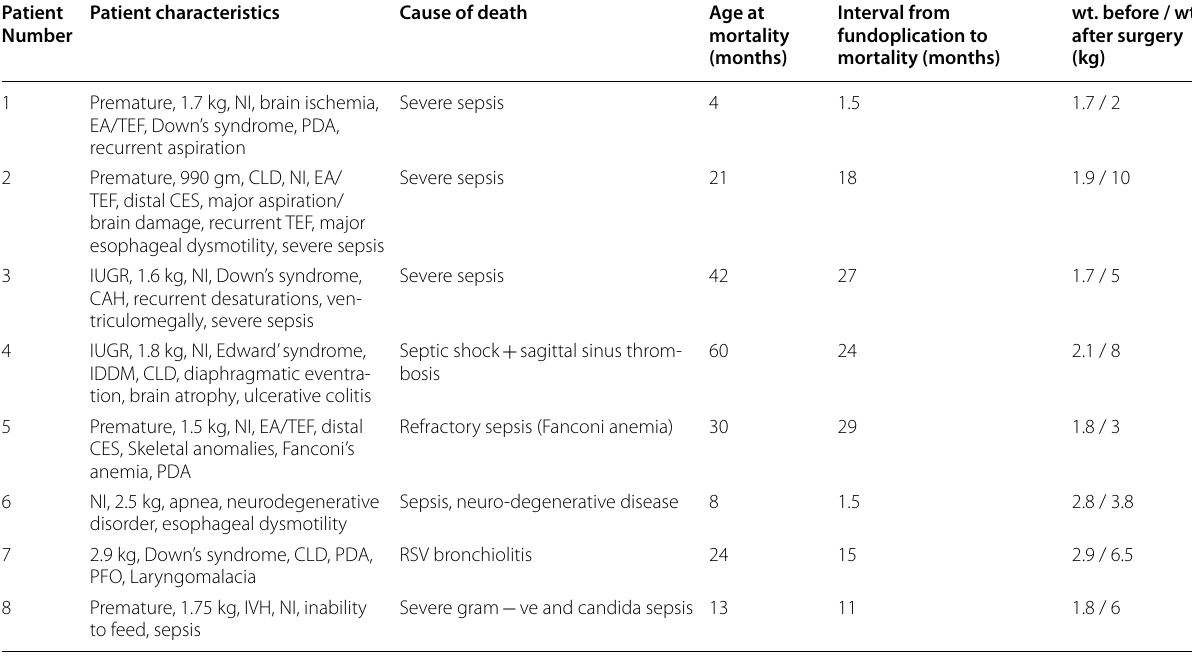
PDA patent ductus arteriosus, IUGR intrauterine growth retardation, CAH congenital adrenal hyperplasia, IDDM insulin-dependent diabetes mellitus, CLD chronic lung disease, PFO patent foramen oval, IVH intraventricular hemorrhage, Wt weight